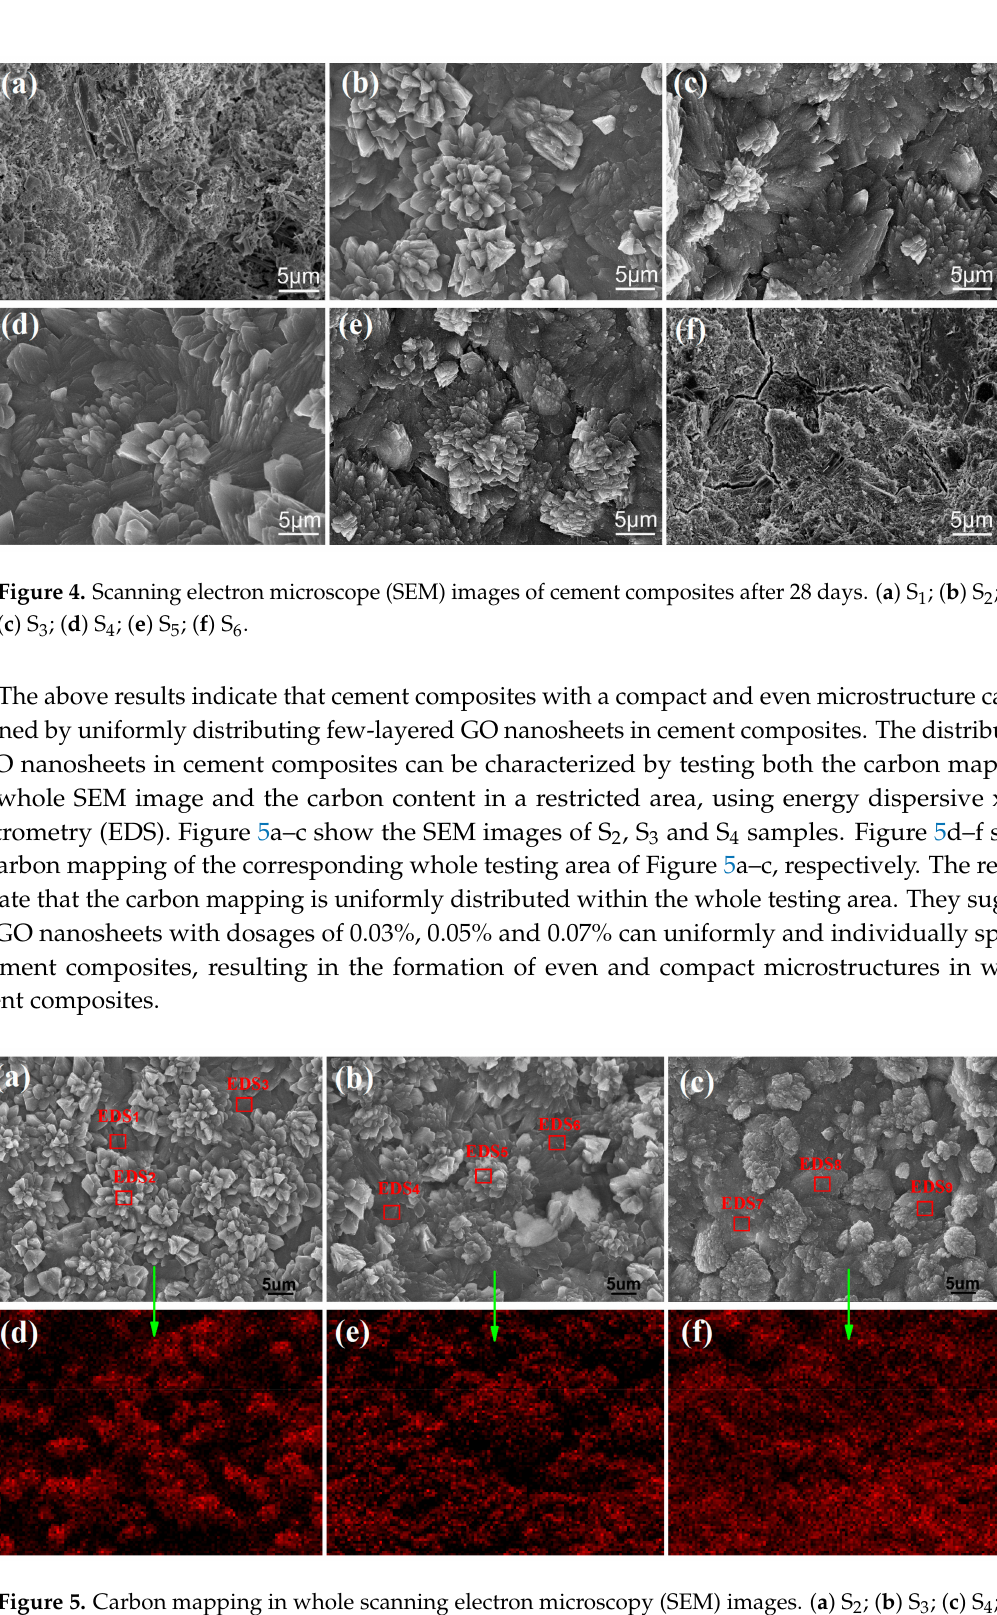
Figure 5. Carbon mapping in whole scanning electron microscopy (SEM) images. ( a ) S 2 ; ( b ) S 3 ; ( c ) S 4 ; ( d – f ) Carbon